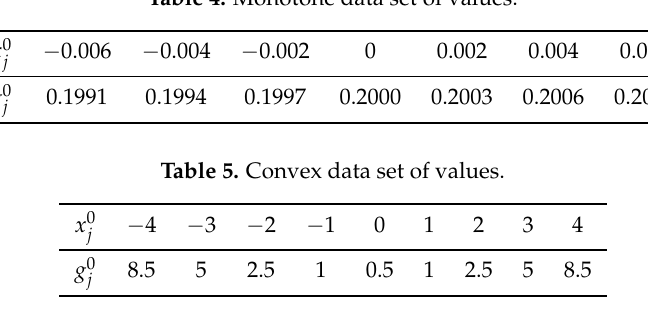
Table 4. Monotone data set of values.